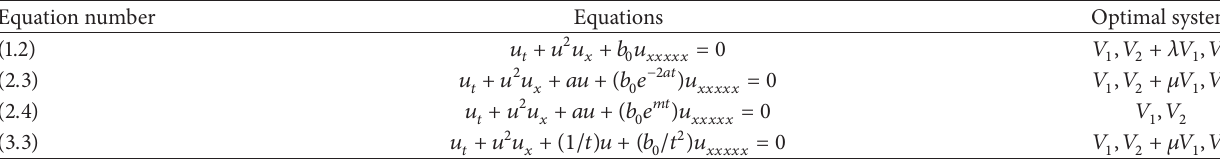
Table 9: Optimal system of subalgebras of some special cases of